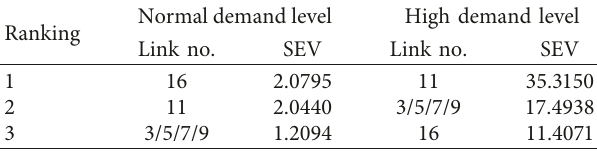
Table 10: The three most vulnerable links considering SEV value. Normal demand Ranking